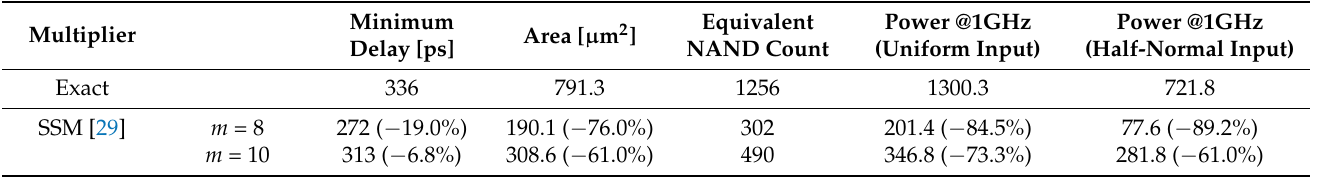
Table 5. Hardware implementation results of the investigated multipliers for n = 16